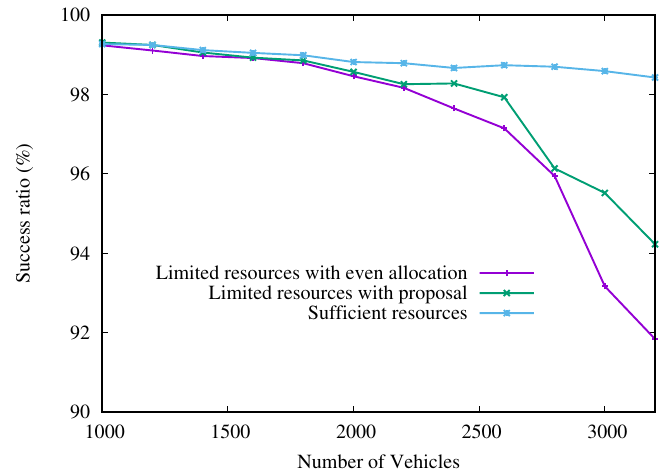
Figure 11. Success ratio performance of the system with coexisting